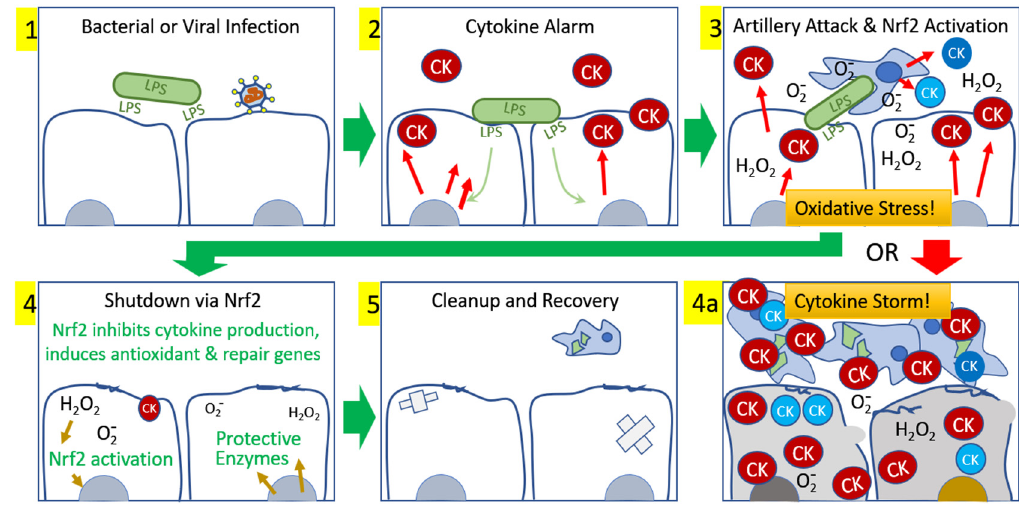
Figure 5. Development and resolution of an acute inflammatory event. ( 1 ) Initiation occurs with bacterial or viral infection, which triggers ( 2 ) local production of cytokines by endothelial cells to call in inflammatory cells to neutralize the invasion. ( 3 ) An attack ensues in which superoxide and secondary oxidants are produced, phagocytosis occurs, and more cytokines are released by the first responders, calling in subsequent waves of activated inflammatory cells. ( 4 ) In young healthy cells, the oxidative stress generated by the battle activates Nrf2 and, within hours, the nearby tissues are inhibiting further tissue cytokine production, rescuing host cells from further damage and permitting ( 5 ) repair, clean up, and recovery. Alternatively, in ( 4a ), older cells deficient in Nrf2 may be unable to mount Nrf2 sufficient activation to break the self-sustaining chain reaction, resulting in an uncontrolled cytokine storm that ultimately destroys the host tissue and leads to death. A more robust activation of the limited Nrf2 available in older cells may be provided by pharmacological or phytochemical Nrf2 activators.